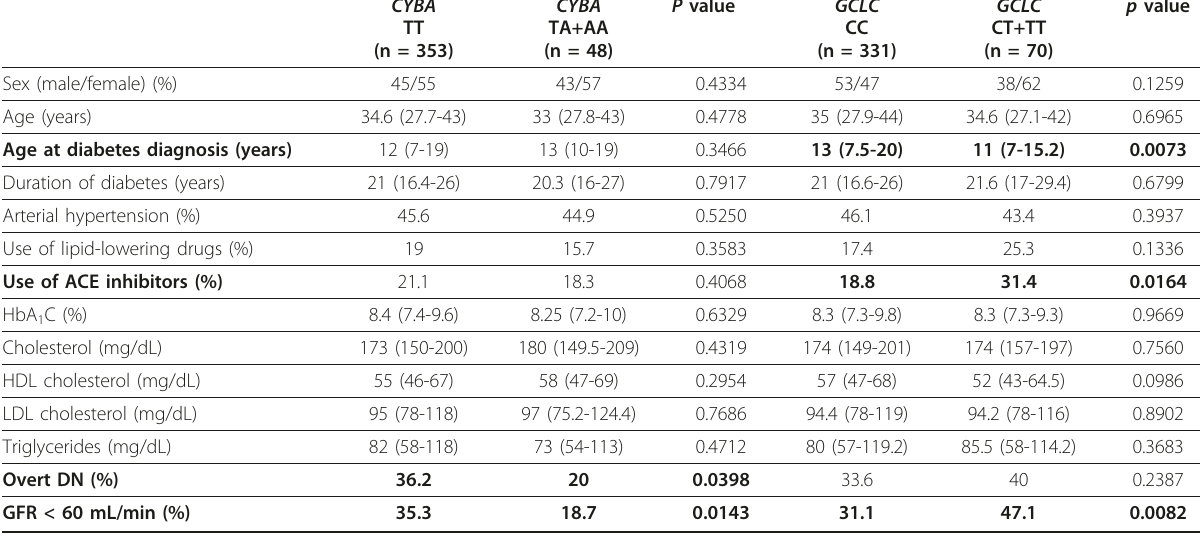
Table 3 Characteristics of type 1 diabetes patients according to the genotypes of CYBA -675 T ® A (unregistered) or GCL C rs17883901